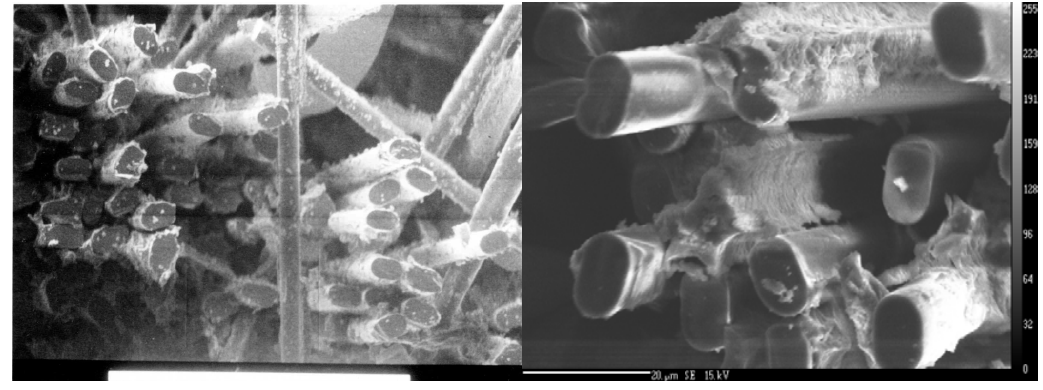
Figure 9. SEM Fracture Surface: Carbon-coated fiber surfaces tested after 250 °C